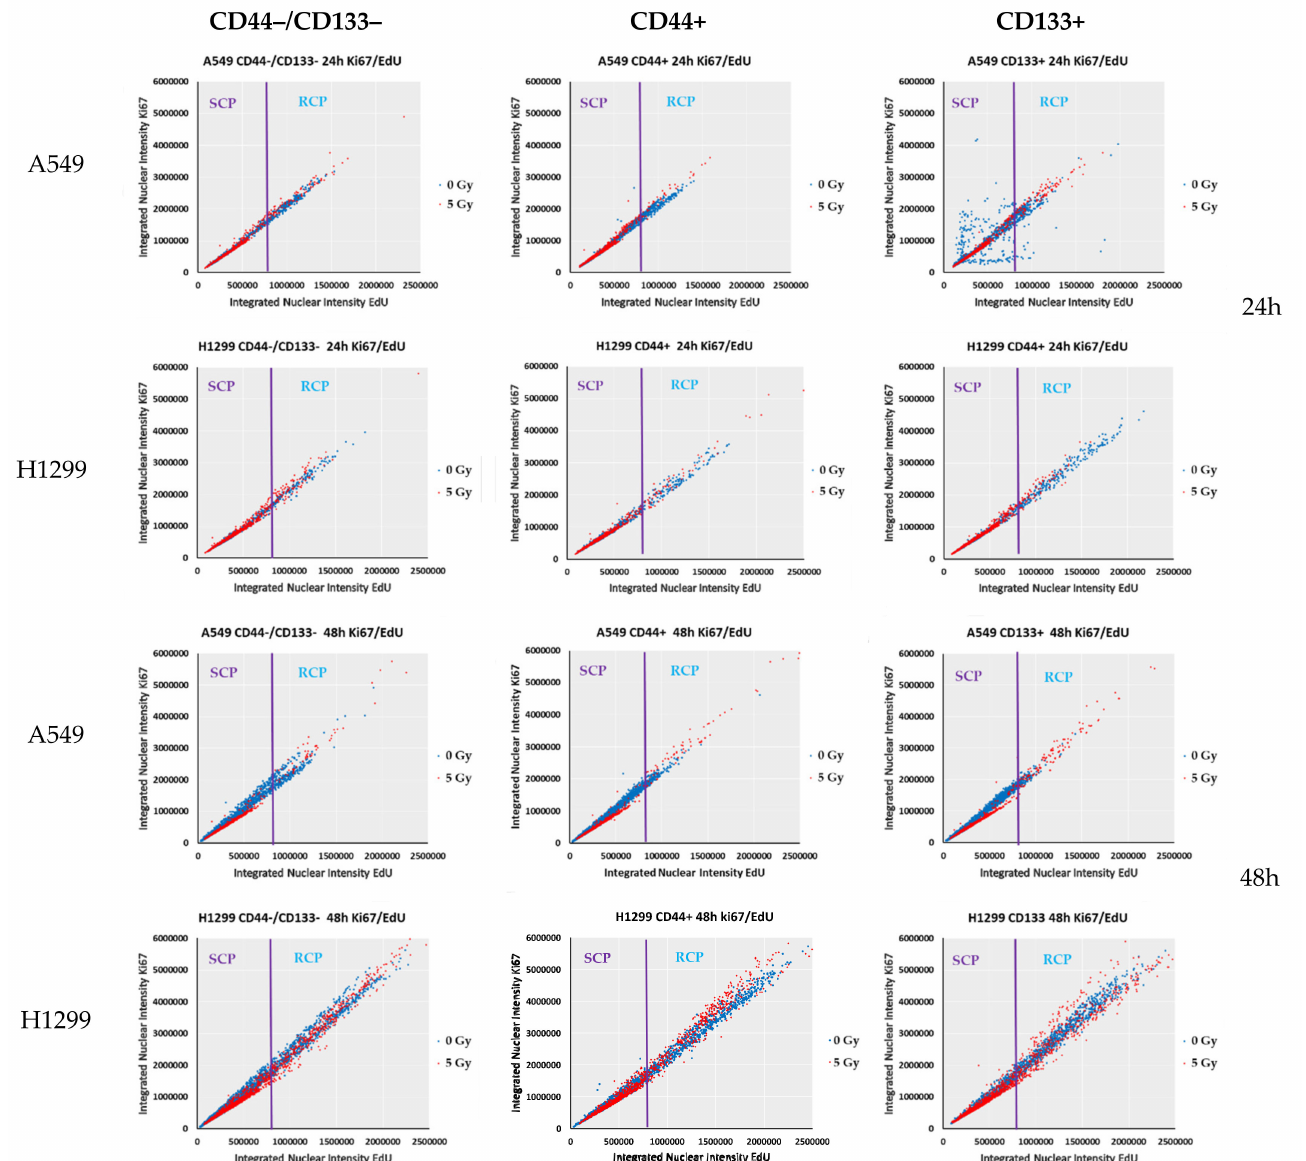
Figure 8. Click-IT EdU- and Ki67-coupled fluorescence measured simultaneously in sorted A549 and H1299 cells. The single-cell EdU and Ki67 quantitative fluorescence analysis is presented to differentiate between slow-cycling/proliferating population (SCP) (Ki67 low /EdU low ) and rapidly cycling/proliferating population (RCP) (Ki67 high /EdU high ) cohorts within each sorted cell population of irradiated (red dots) and non-irradiated (blue dots, control) cells at 24 h and 48h of cultivation after 5 Gy irradiation. Data are representative of three independent